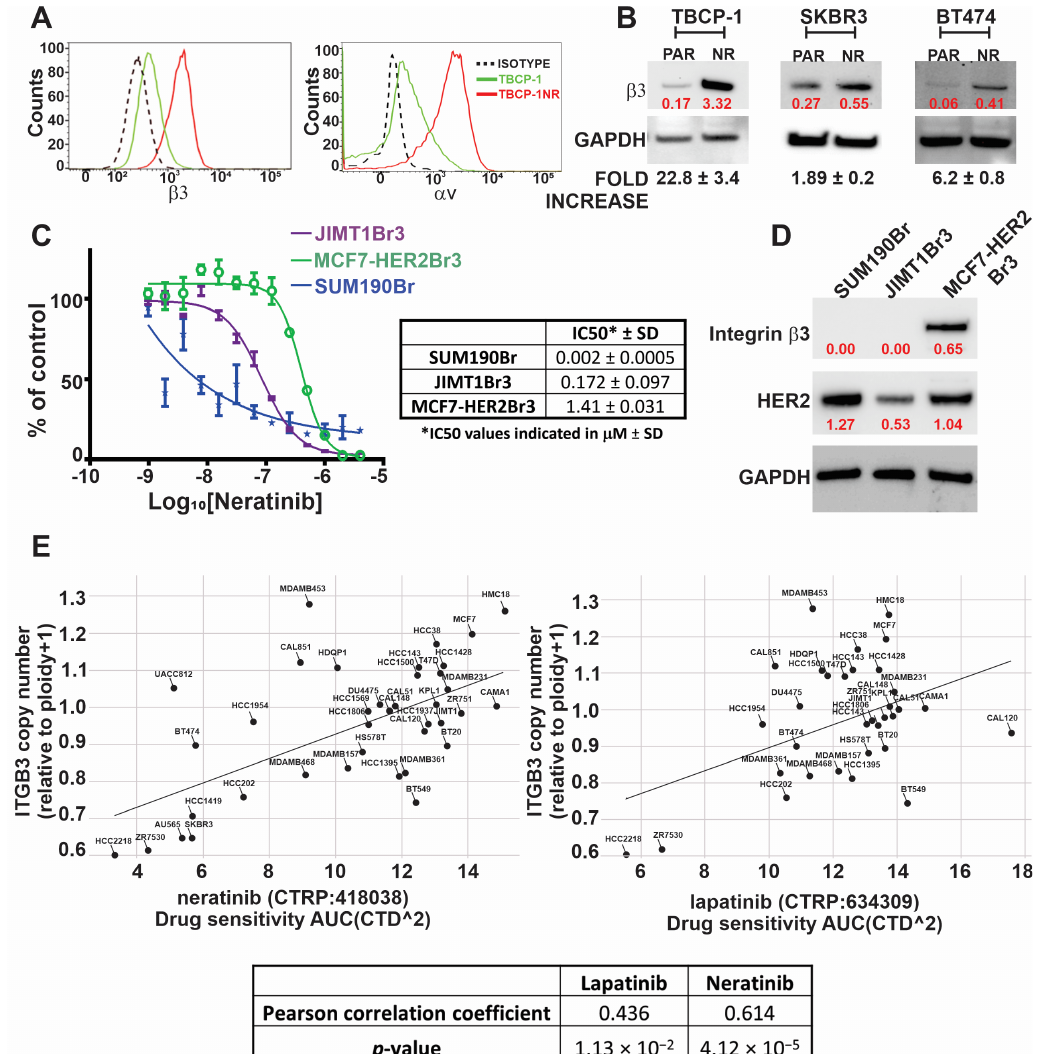
Figure 2. TKI resistance is associated with increased expression of α v β 3 integrin. ( A ) Cell surface expression of the α v and β 3 integrin subunits was analysed in TBCP-1 or TBCP-1NR cells by flow cytometry. Black dashed line = isotype control, green = TBCP-1 and red = TBCP-1NR. ( B ) Expression levels of integrin β 3 were compared in mouse or human TKI-sensitive and resistant pairs by Western blot analysis of whole cell lysates and were normalised relative to GAPDH. The data show represen- tative blots and mean fold increase relative to matched sensitive pairs ± SD from three independent lysates ( n = 3). The intensity ratio of each band relative to GAPDH is indicated in red. ( C ) Sensitivity of the indicated human brain metastatic HER2-positive breast cancer cell lines to neratinib was determined in a 3-day SRB colourimetric assay. The data show a representative curve and mean IC50 values ± SD for each cell line from three independent experiments ( n = 3). ( D ) Western blot analysis of integrin β 3 and HER2 expression in whole cell lysates of human brain metastatic lines. GAPDH was used as the loading control. The intensity ratio of each band relative to GAPDH is indicated in red. ( E ) The association between TKI resistance and integrin β 3 expression in breast cancer cell models was analysed using Cancer Dependency Map (DepMap) analysis tool. The data show the association of ITGB3 copy number (log2 relative to ploidy +1, in 21Q1 dataset) with neratinib (AUC values from CTRP: 418,038 dataset) or lapatinib sensitivity (AUC values from CTRP:634309 dataset) for a panel of 38 breast cancer cell lines. The strength of the linear association was determined by measurement of Pearson coefficient and linear regression t-test was used to determine the slope of the regression and statistical significance, p < 0.05 was considered significant. The uncropped blots are shown in Supplementary File